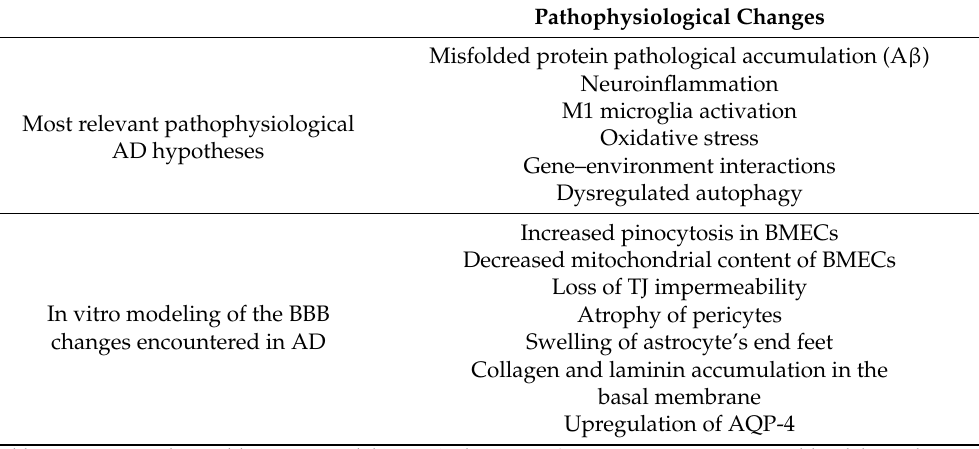
Table 4. Translating the pathophysiological AD hypotheses in accurate in vitro models of the